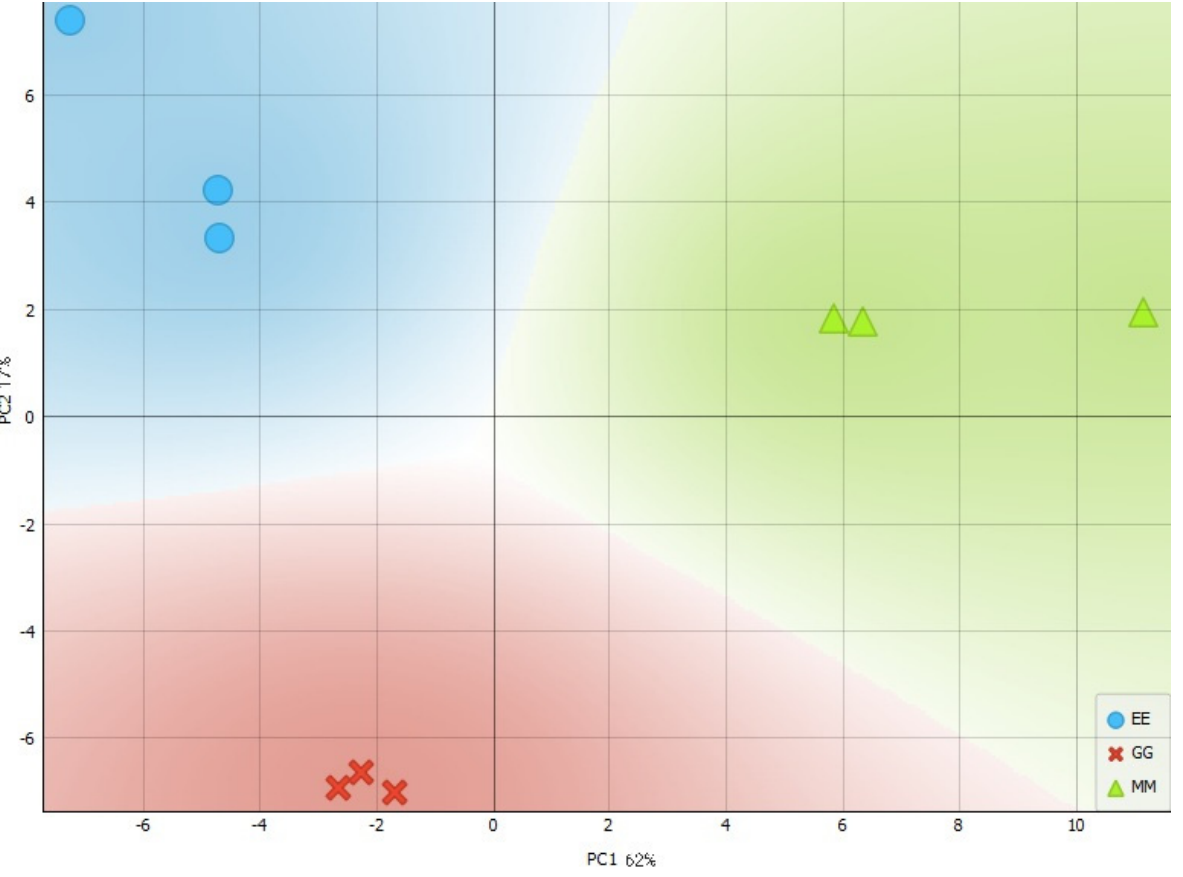
Figure 2. Score plot of PCA. The circle shape represents EE ginger rhizome extract; the cross shape represents GG ginger rhizome extract; and the triangle shape represents MM ginger rhizome extract.